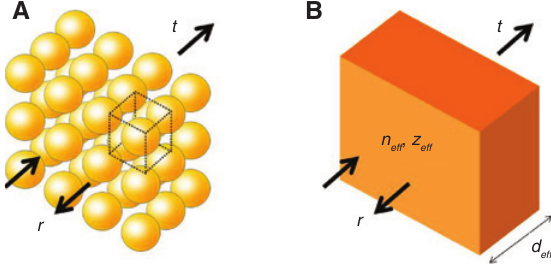
Figure 1: Homogenization of metamaterials. (A) Schematic of a gold nanoparticle array. (B) The homogenized slab with the effective parameters. r and t are the reflection and transmission coefficients,